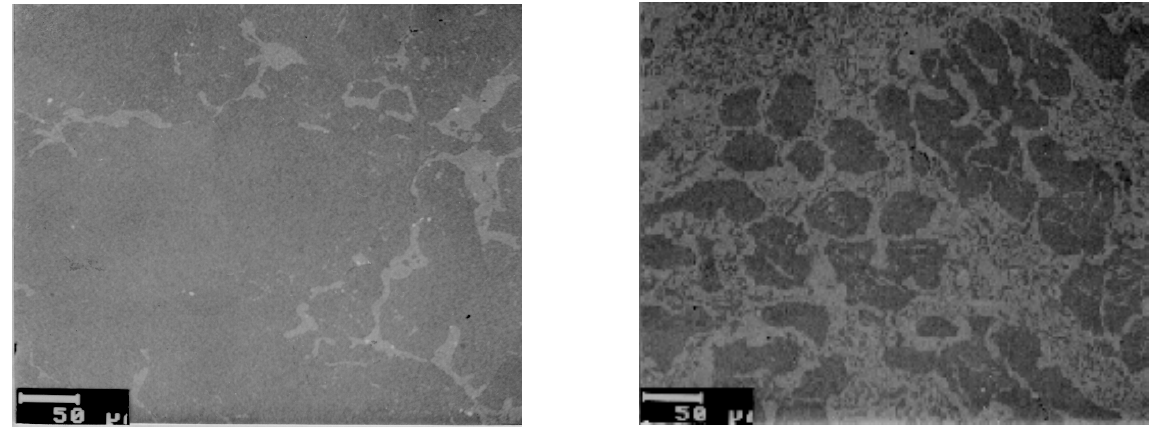
Figure 1. Microstructure (BEI) of NiAl-20Fe (a) and NiAl-30Fe (b) alloys. Dark phase: β ; light phase: γ .